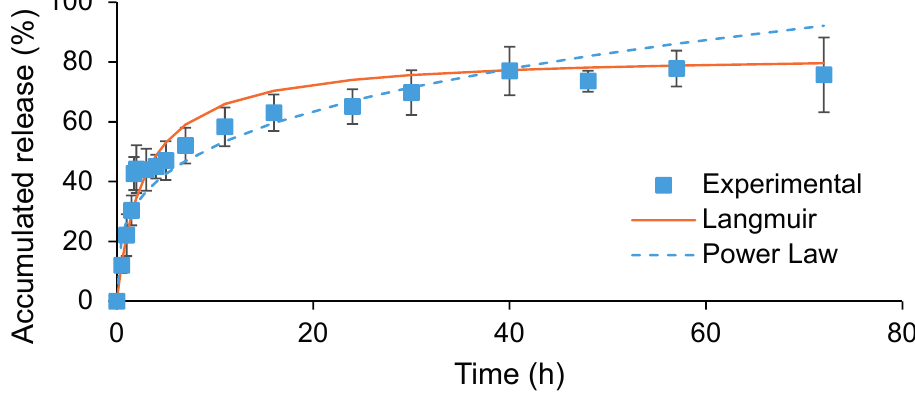
Figure 5. In vitro drug release profile of GCV from GCV-PCL-chitosan in PBS at 37 °C (mean ± SD, n =